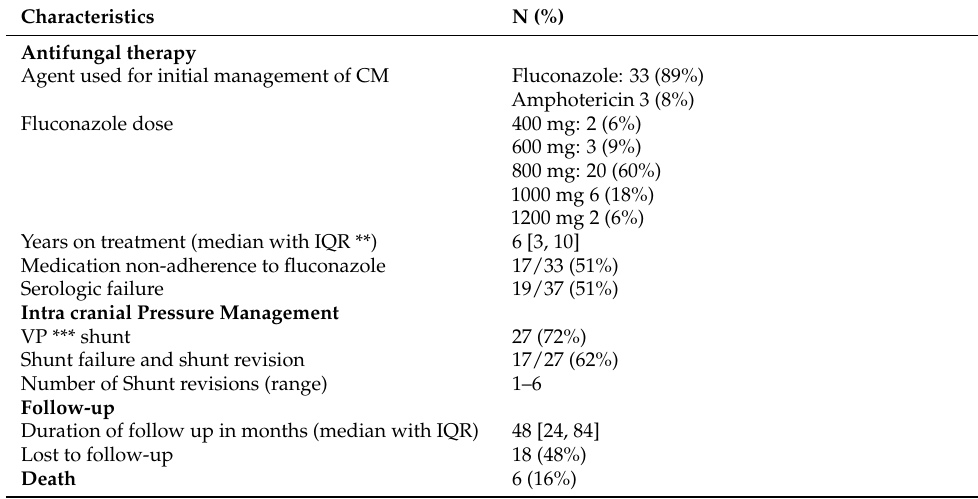
Table 2. Management and Follow-up of CM * (N =